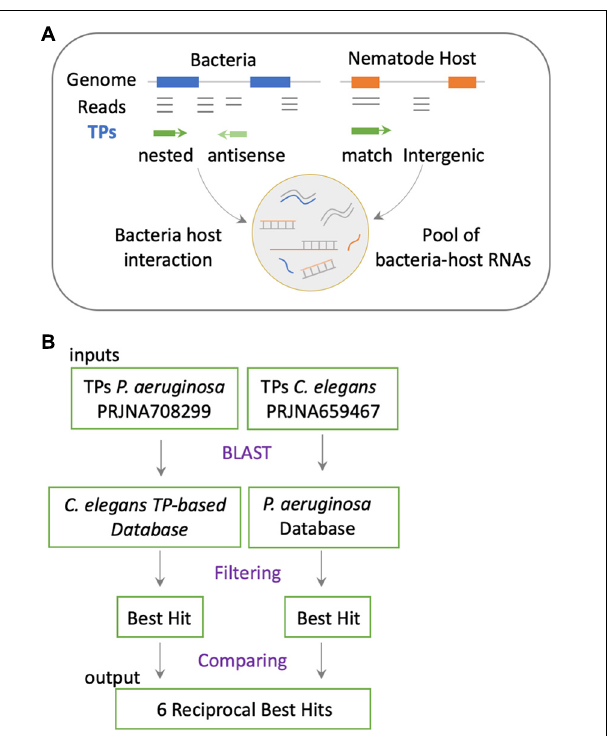
FIGURE 2 | (A) Representation of the putative mechanism of interaction based on transcripts expressed in holobiont and that have the potential of sequence matching. This approach considers actual transcriptomic data of both species in a synchronous paradigm. (B) Methodological flow to address the mechanism proposed in panel (A)